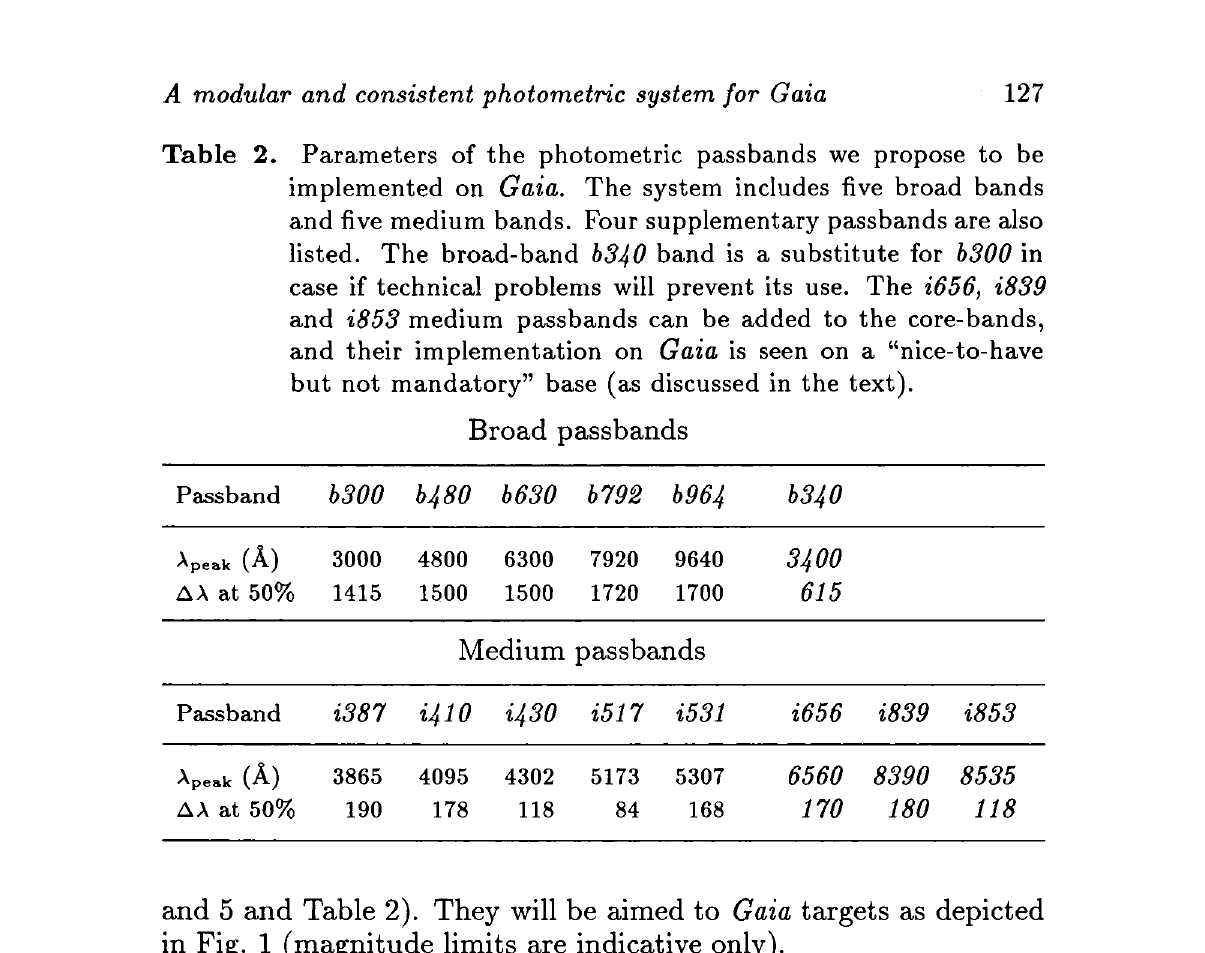
Parameters of the photometric passbands we propose to be implemented on Gaia. The system includes five broad bands and five medium bands. Four supplementary passbands are also listed. The broad-band b340 band is a substitute for b300 in case if technical problems will prevent its use. The i656, i839 and i853 medium passbands can be added to the core-bands, and their implementation on Gaia is seen on a "nice-to-have but not mandatory" base (as discussed in the